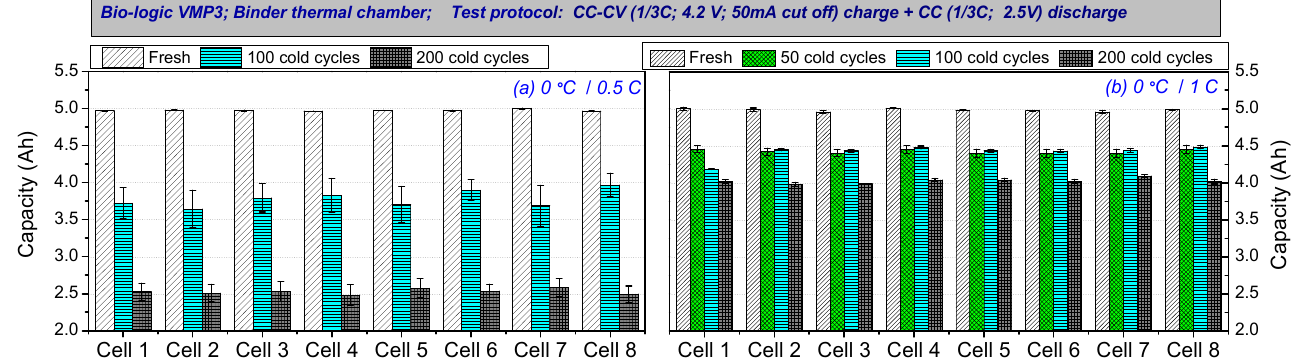
Figure 3. Capacity snapshot tested at 25 °C and 1/3 C for batteries that experienced a 0 °C cold cycling under the current rates ( a ) 0.5 C; ( b ) 1 C.